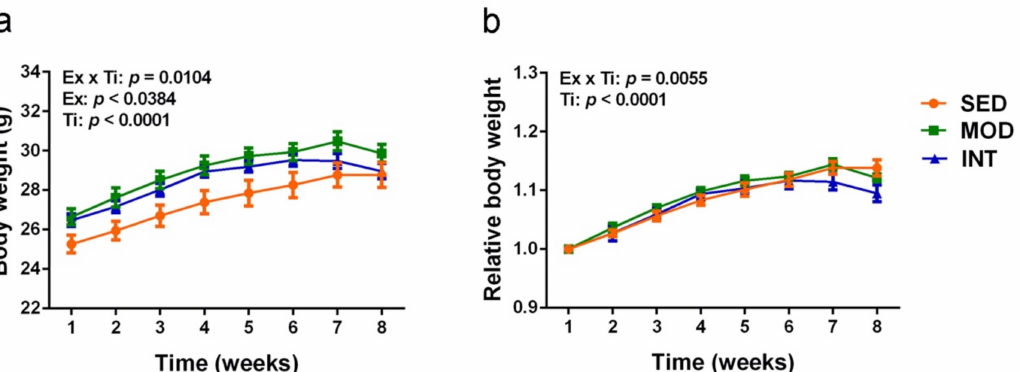
Figure 1. Daily treadmill training induced a body weight decrease in mice. ( a ) Body weight curves; ( b ) relative body weight curves. Experimental groups: SED, sedentary; MOD, moderate training; INT, high-intensity training. Values are mean ± SEM (( a , b ) SED n = 15, MOD n = 15, INT n = 12). ANOVA statistics: Ex, factor exercise; Ti, factor time; see text for post hoc results.